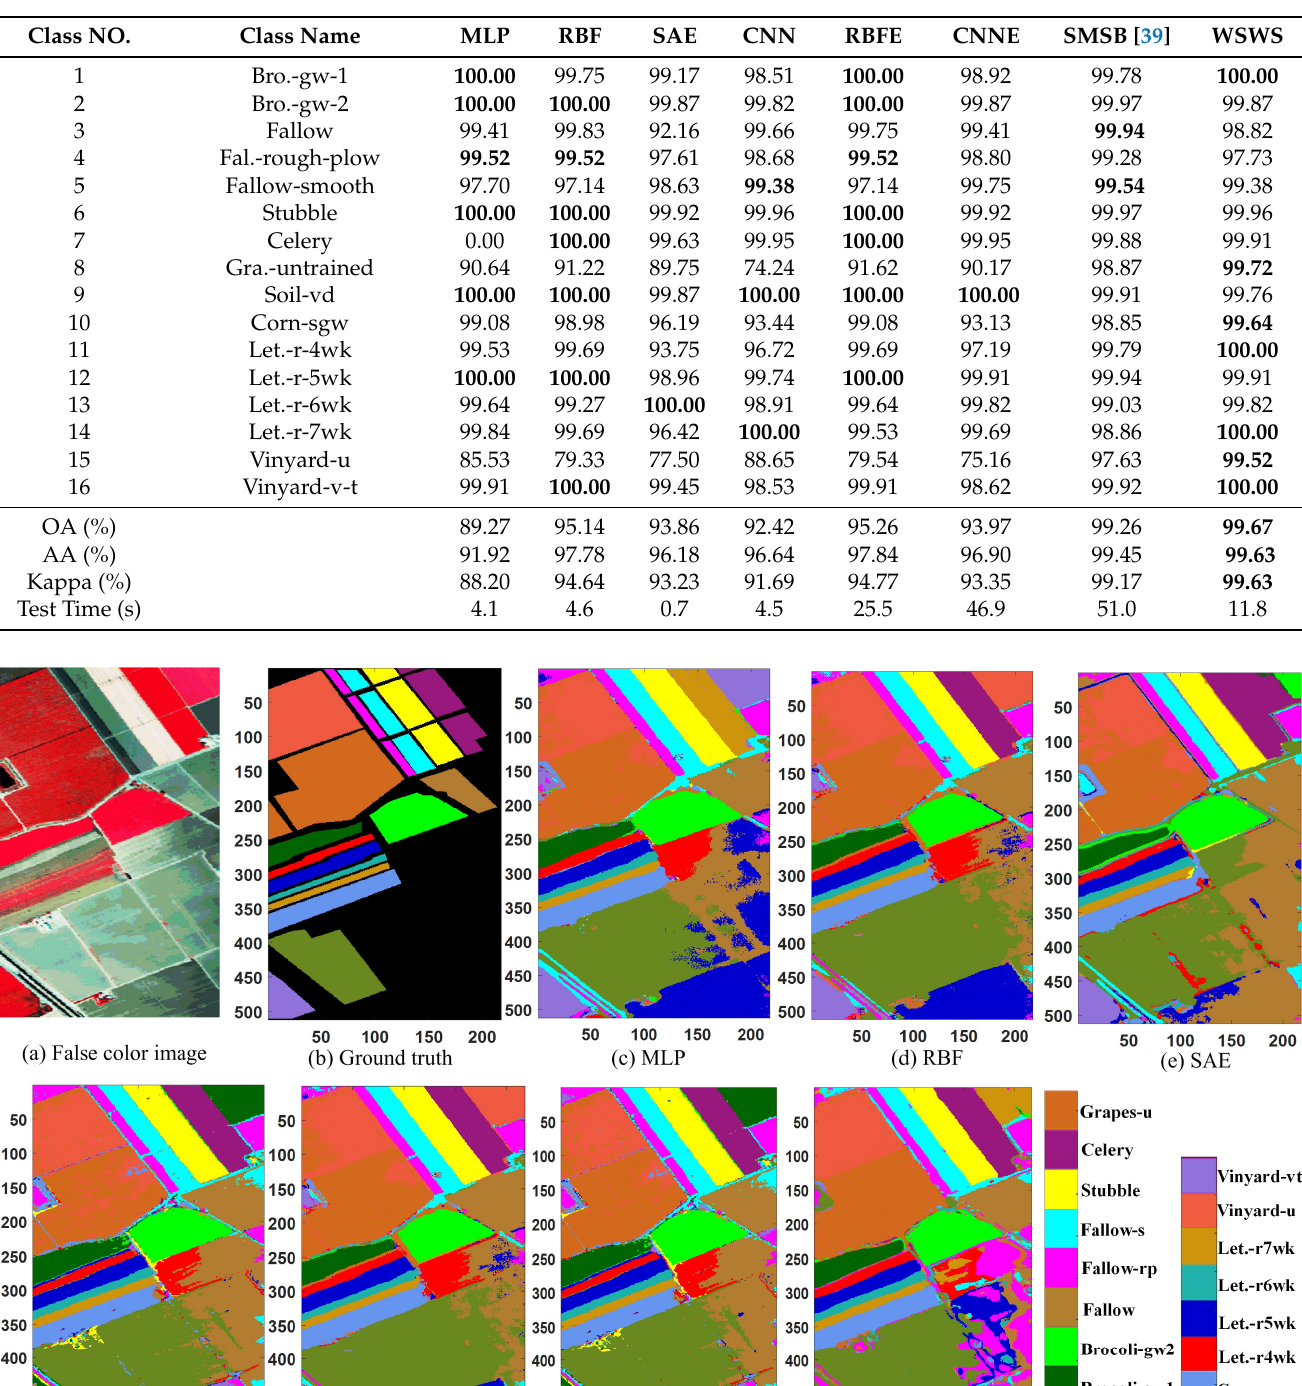
Table 5. Classification results of different methods for Salinas.